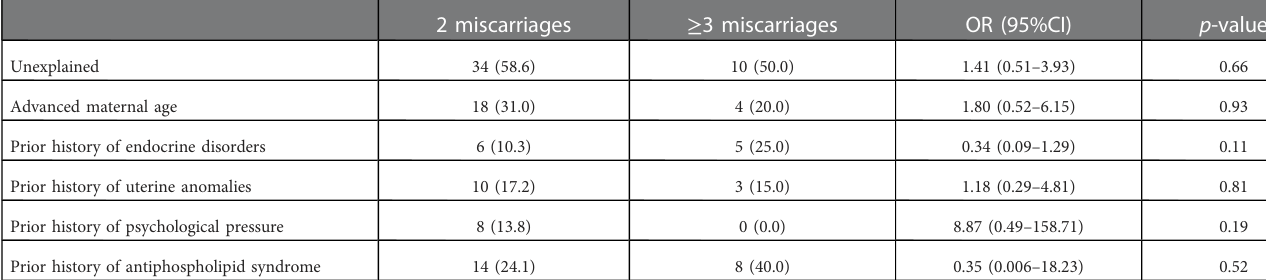
TABLE 4 Risk factors of RPL among participants with prior RPL according to ASRM/ESHRE (2 RPL) and wHO/RCOG ( ≥ 3 RPL) criterion.